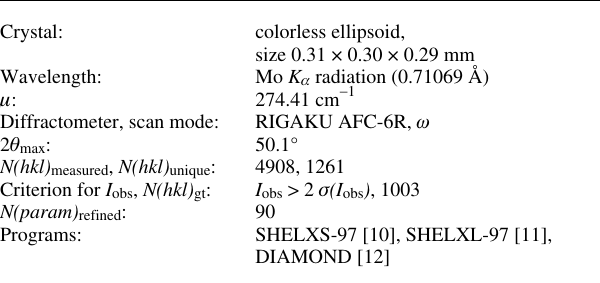
1. Thallium hexaaquamagnesium(II) selenate, [Mg(H Tl 2 Table 1. Data collection and handling.